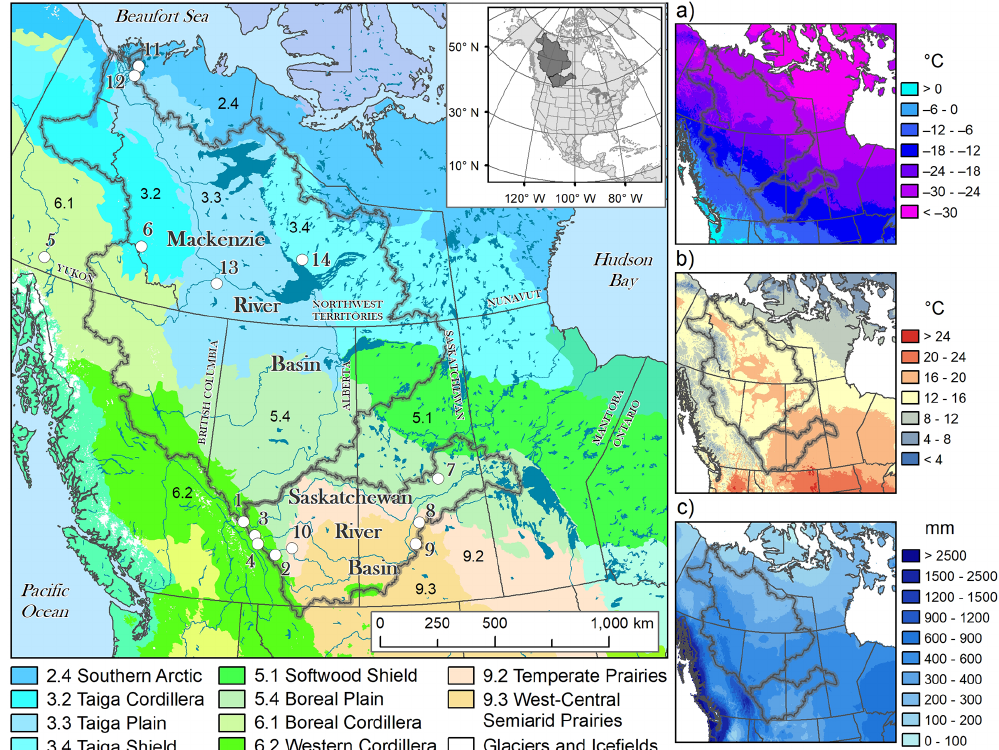
Figure 1. Map of the CCRN study domain across the interior of western Canada. The Mackenzie and Saskatchewan River Basins are shown and their location within North America is indicated in the inset map. Land cover and physiography are depicted by the Level II Ecological Regions of North America, with the naming convention and symbology of CEC (1997). The panels on the right show (a) January mean air temperature, (b) July mean air temperature, and (c) annual total precipitation. The locations of CCRN Water, Ecosystem, Cryosphere, and Cli- mate (WECC) observatories are indicated by circles: (1) Columbia Icefield, (2) Marmot Creek, (3) Peyto Glacier, (4) Lake O’Hara, (5) Wolf Creek, (6) Brintnell-Bologna Icefield, (7) Boreal Ecosystem Research and Monitoring Sites (BERMS), (8) St. Denis National Wildlife Area, (9) Brightwater Creek/Kenaston Mesonet Site, (10) West Nose Creek, (11) Trail Valley Creek, (12) Havikpak Creek, (13) Scotty Creek, (14) Baker Creek. Source data are from the North American Environmental Atlas (http://www.cec.org/north-american-environmental-atlas/, last access: 6 April 2021), the National Hydro Network (http://www.geobase.ca, last access: 6 April 2021), WorldClim Global Climate Data (http://worldclim.org/version2, last access: 6 April 2021), and the Commission for Environmental Cooperation (http://www.cec.org, last access: 6 April